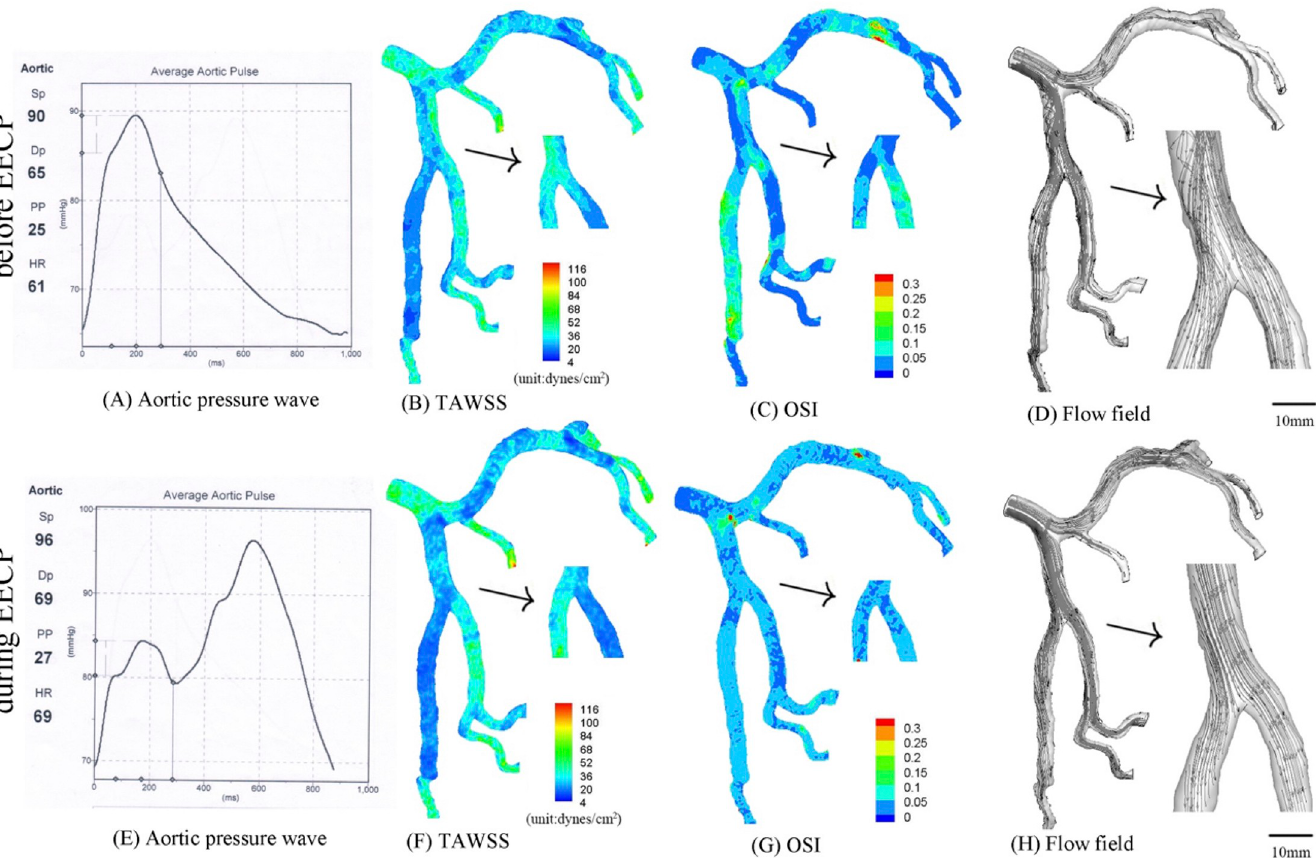
Fig 2. (A-D) Measured aortic pressure wave (A), TAWSS (B), OSI (C) and flow field (D) in the epicardial LMCA tree of a representative patient before EECP; (E-H) measured aortic pressure wave (E), TAWSS (F), OSI (G) and flow field (H) in the epicardial LMCA tree of the patient during EECP. The small figures for TAWSS and OSI show the posterior view. The small figures for flow field show the zoomed view.